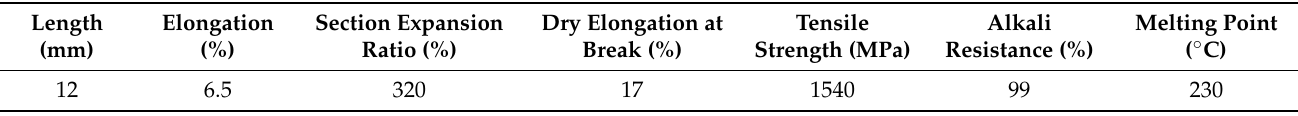
Table 3. Physical indices of the PVA